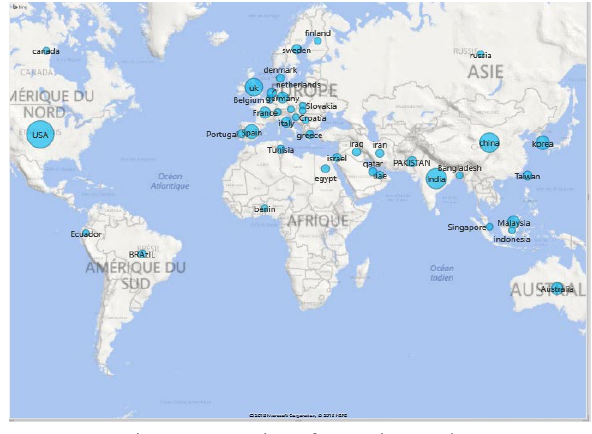
Figure 7. Mapping of countries number